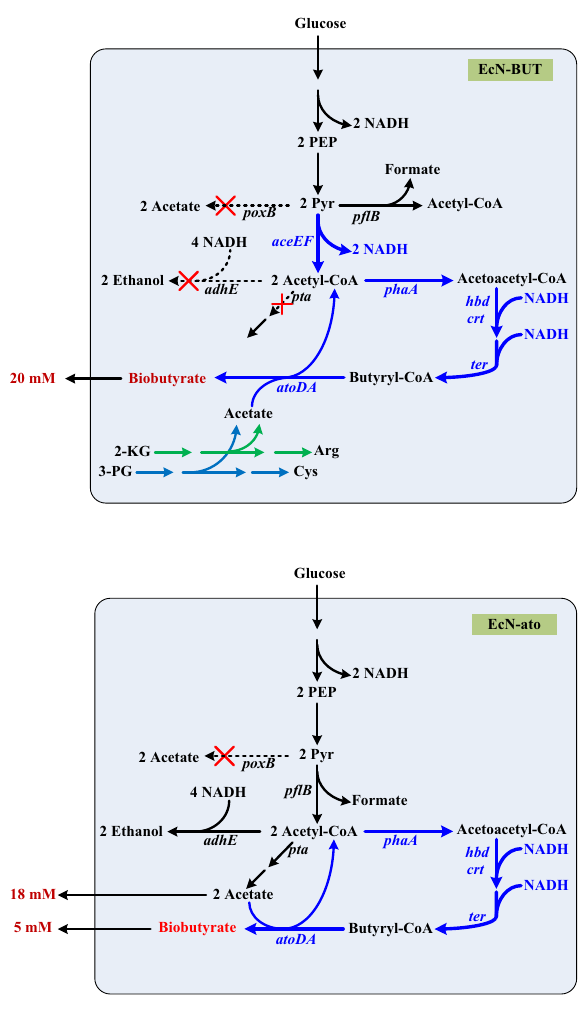
Figure 1. Schematic illustration of the metabolic pathway leading to biobutyrate from glucose. The strategy of metabolic engineering was applied to rewire EcN metabolism for the synthesis of biobutyrate. Pathways of enhancement and of new construction were indicated by solid lines (blue) while pathways of blockage were marked with “X” (dotted lines). The genetic construction resulted in the bacterial vector including EcN-BUT (top) and EcN-ato (bottom). After the fermentation, the bacterial production of acetate (mM) or biobutyrate (mM) was indicted in the Figure. Acetate is produced during the biosynthesis of Arg from 2-KG and of Cys from 3-PG in EcN-BUT. The genes involves in the metabolic pathway: aceEF pyruvate dehydrogenase complex, adhE aldehyde-alcohol dehydrogenase, atoDA acetoacetyl-CoA transferase, pta phosphate acetyltransferase, poxB pyruvate oxidase, phaA β-ketothiolase, hbd 3-hydroxybutyryl-CoA dehydrogenase, crt crotonase, ter trans-enoyl-CoA reductase. Arg argine, Cys cysteine, 2-KG 2-ketoglutarate, PEP phosphoenolpyruvate, 3-PG 3-phosphoglycerate, Pry